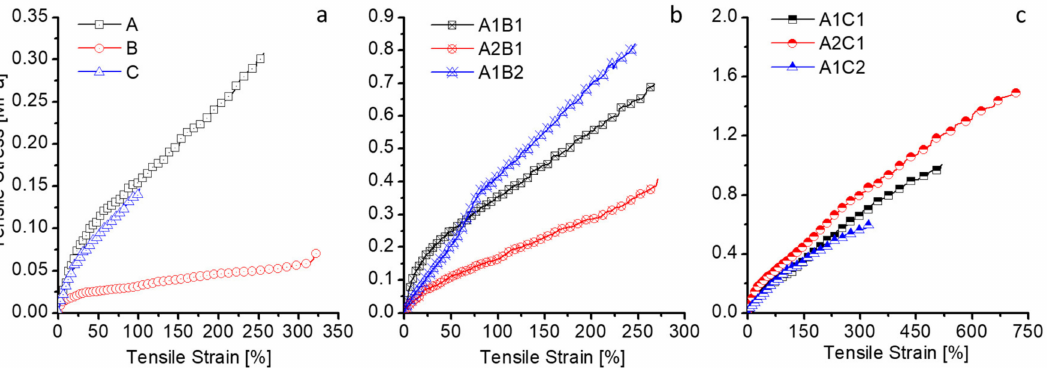
Figure 9. The mechanical properties (stress-strain curves) of the reference samples ( a ) and of the IPNs ( b , c ). Single damping peaks are observed in the DMA scans (Figure 10), conforming a substantial interpenetration of the two networks. The corresponding damping peak tem- peratures, which are taken as glass transition temperatures (T g ), are listed in Table S3. No important variations of melting temperatures can be observed, which are in good correlation with DSC (Figure 7). The shapes of tan δ peaks does not change too much, whereas the intensity and the position of the damping peak changes directly related to the A and C ratio. The presence of higher ratio of A enhances the mobility of the IPN, and the height of tan δ peak increases up to 0.11. The greater the C content is, the more rigid is the IPN structure. The lowest damping peak intensity (0.08) observed for the A1C2